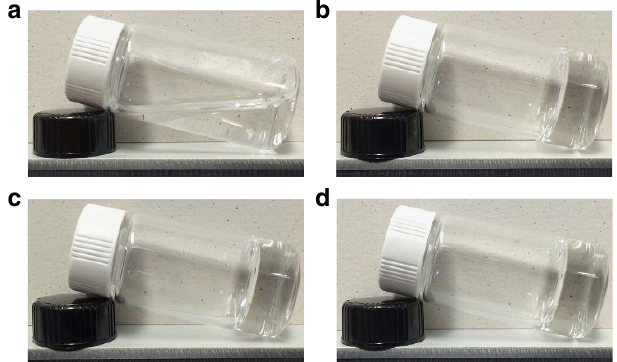
Figure 2 | Gelation behaviour of PAM/CNS NC gels. The polymer and tricalcium silicate concentrations were fixed at 20wt% and 500p.p.m., respectively. ( a ) After being maintained at 0 (cid:2) C and 1atm for 10 days, gelation did not start at 1atm. ( b ) After being maintained at 0 (cid:2) C and 1atm for 1 day, gelation started after 3h at 0.01atm. ( c ) After being maintained at 0 (cid:2) C and 1atm for 3 days, gelation started after 3h at 0.01atm. ( d ) After being maintained at 0 (cid:2) C and 1atm for 5 days, gelation started after 3h at 0.01atm. PAM/CNS NC gels represent polyacrylamide/calcium hydroxide nano-spherulites nanocomposite hydrogels.